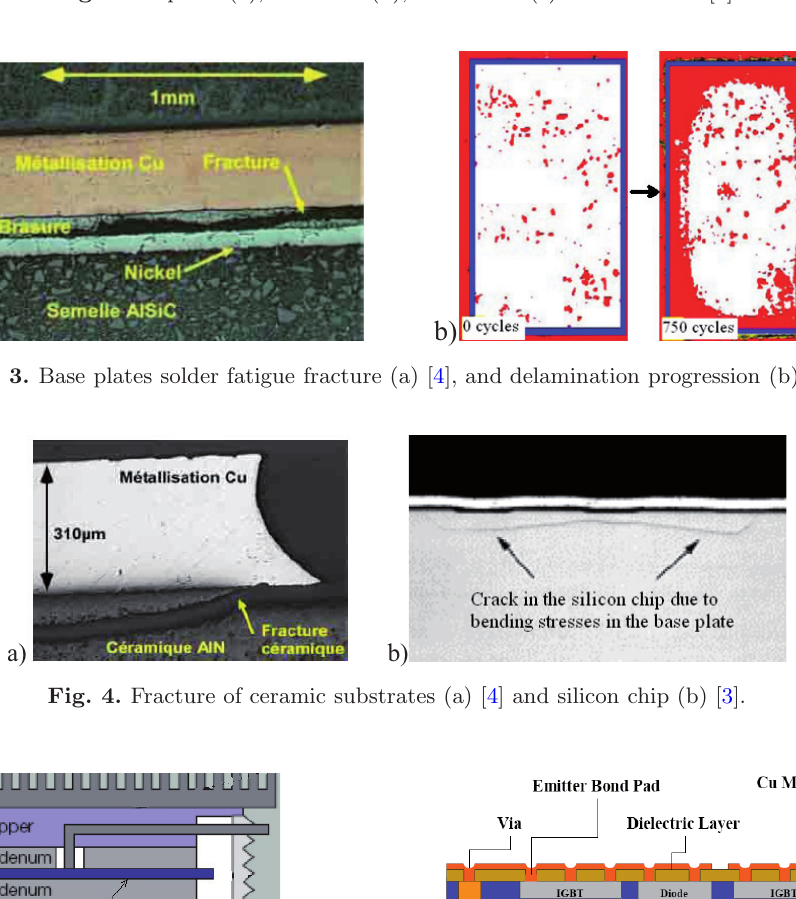
Fig. 2. Rupture (a), corrosion (b), and lift-off (c) of wire bonds [3].